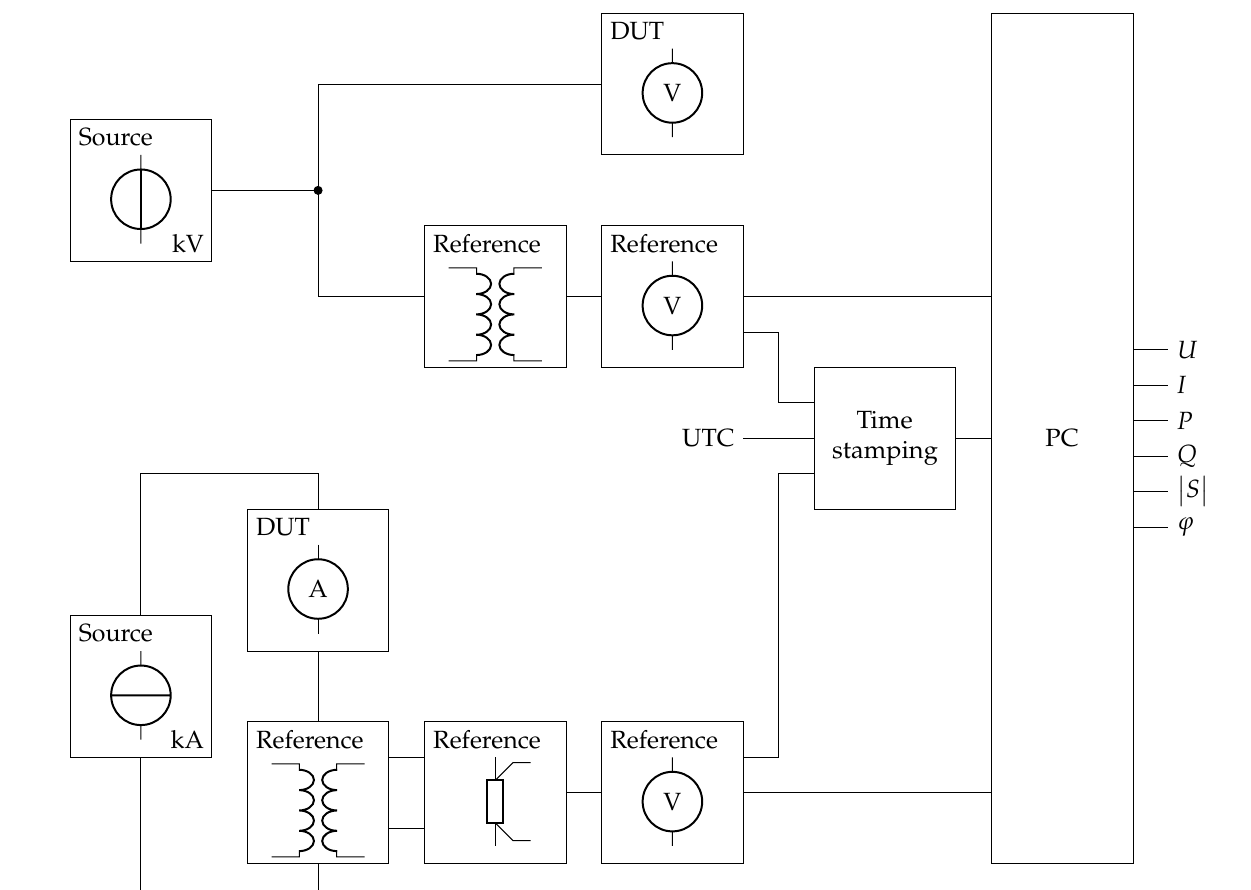
Figure 2. Primary power standard for high currents and high